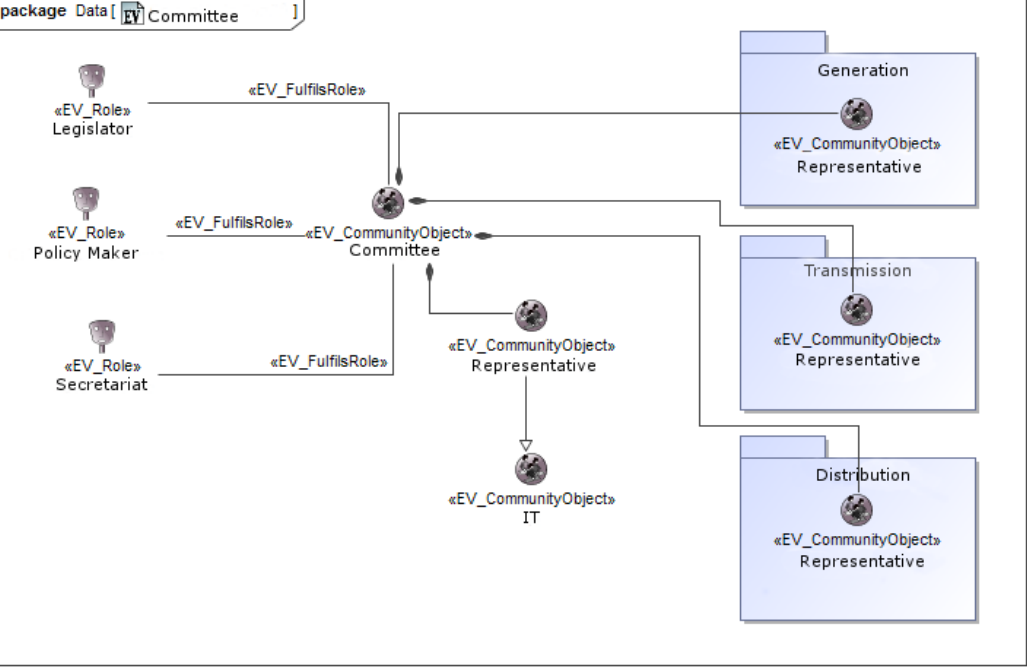
Figure 9. Community Committee and its respective